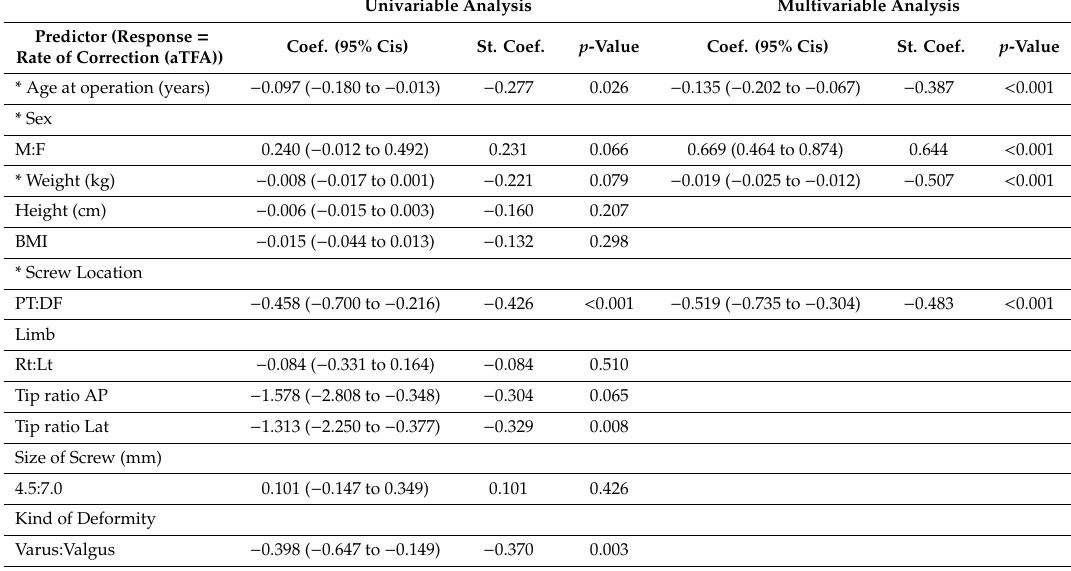
Table 4. Results of univariable and multivariable linear regression analysis using the correction rate (aTFA) as a response.